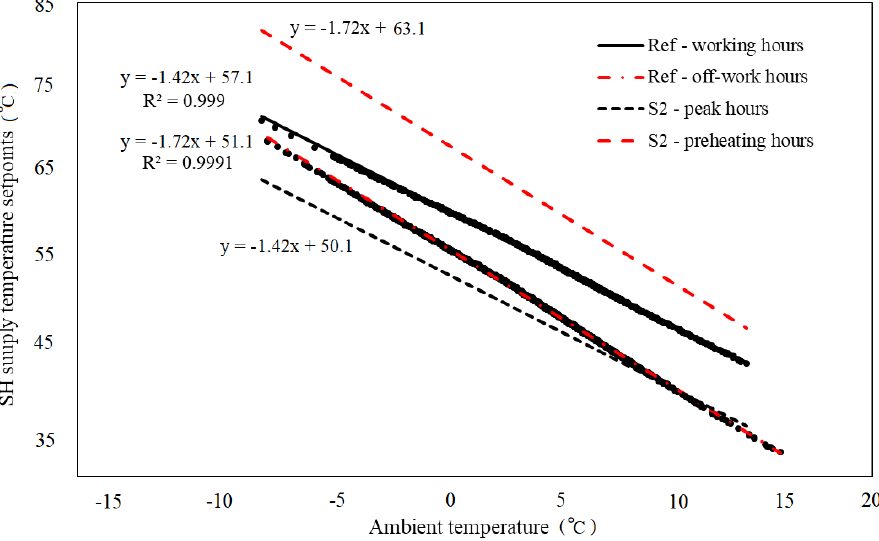
Figure 7. Weather compensation curves for the ref. case and scenario 2 (S2) as an example.